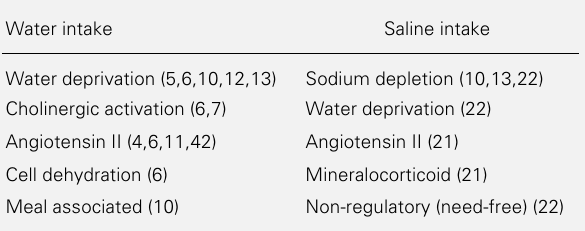
Table 1 - Models of water and saline intake inhibited by clonidine. Each model corresponds to at least one mechanism that induces water or saline intake and is inhibited by clonidine acting in the brain. Numbers in parentheses indicate the reference for each model in the